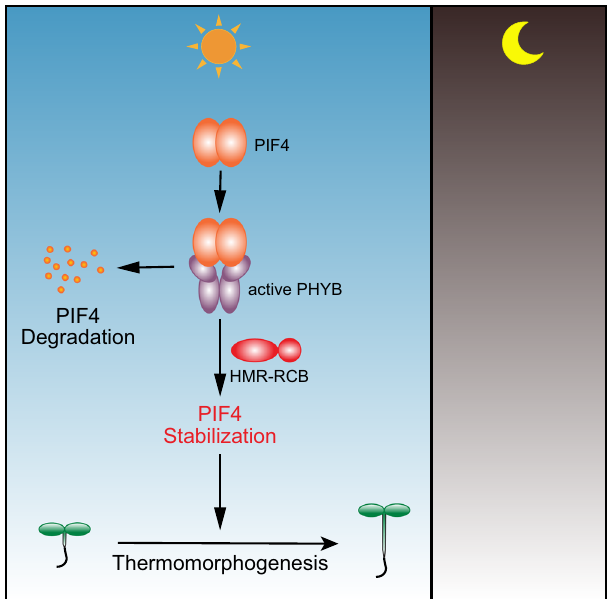
Fig. 7 Model for daytime PIF4 stabilization in thermomorphogenesis. During the daytime under LD conditions, PIF4 interacts with active PHYB and is promoted for degradation. HMR and RCB collaboratively enable thermomorphogenesis by stabilizing